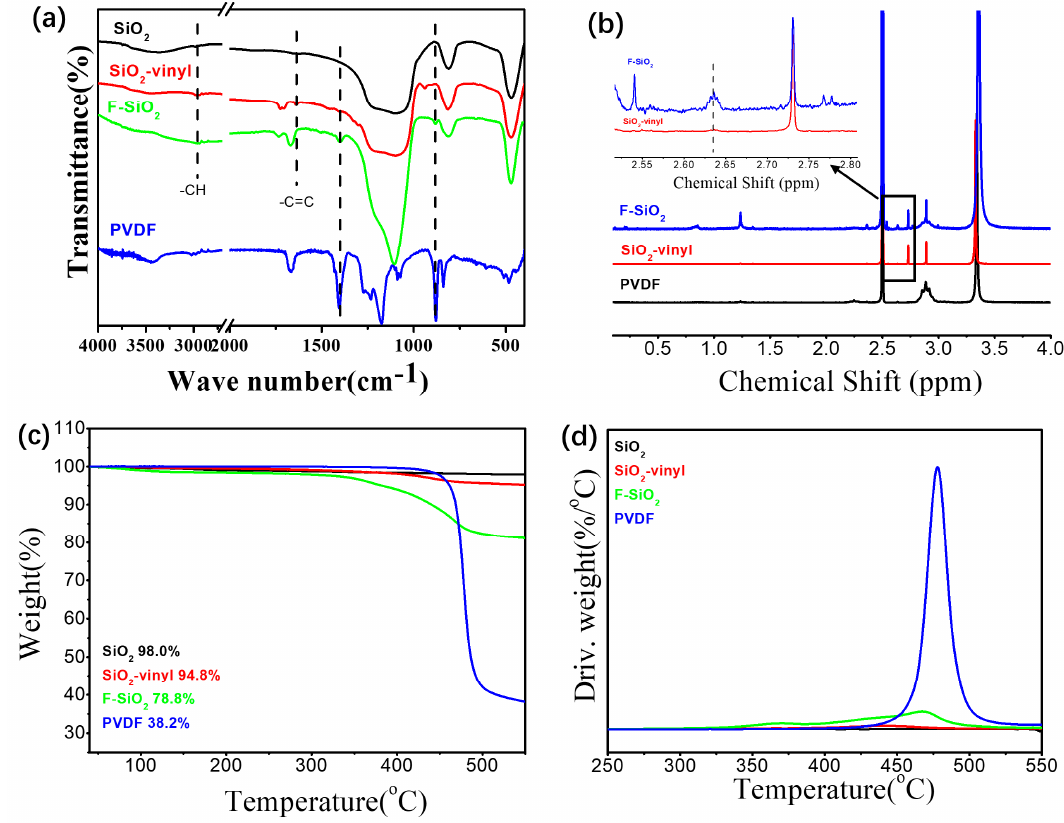
Figure 3. FT-IR ( a ), 1 H-NMR ( b ), TGA ( c ), and DTG ( d ) curves of the SiO 2 , SiO 2 -vinyl, F-SiO 2 , and polyvinylidene fluoride